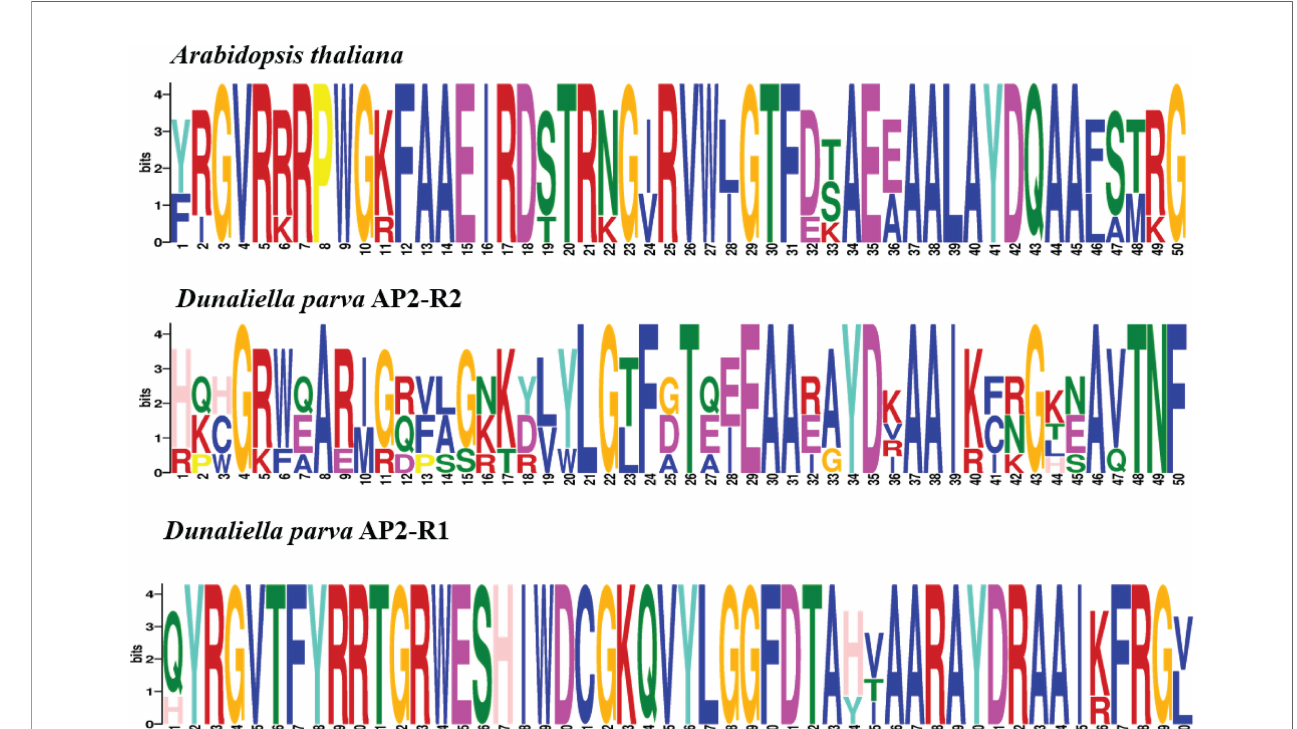
FIGURE 4 | The conserved amino acid residues in the AP2 domain from the D. parva and A. thaliana AP2 subfamily. The domain was analyzed by MEME software. The horizontal number indicates the amino acid site; each site represents a stack. The height of character represents the frequency of the amino acid.